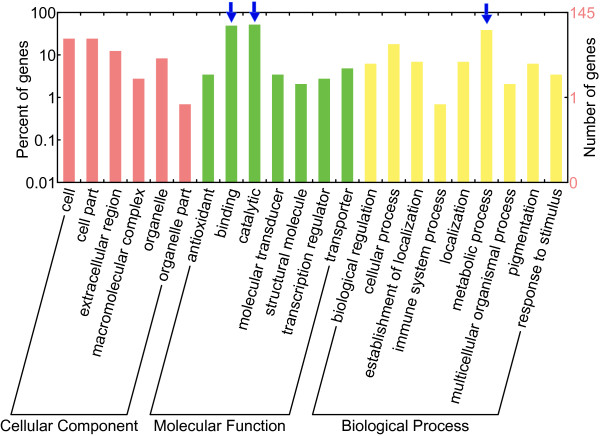
GO annotation of the genes in SDs. Gene classes overrepresented in SDs were indicated by blue arrow. In molecular function, binding and catalytic were much higher than other categories (**p < 0.01, T-test). In biological process, metabolic process was much higher than other categories (*p < 0.05, T-test).